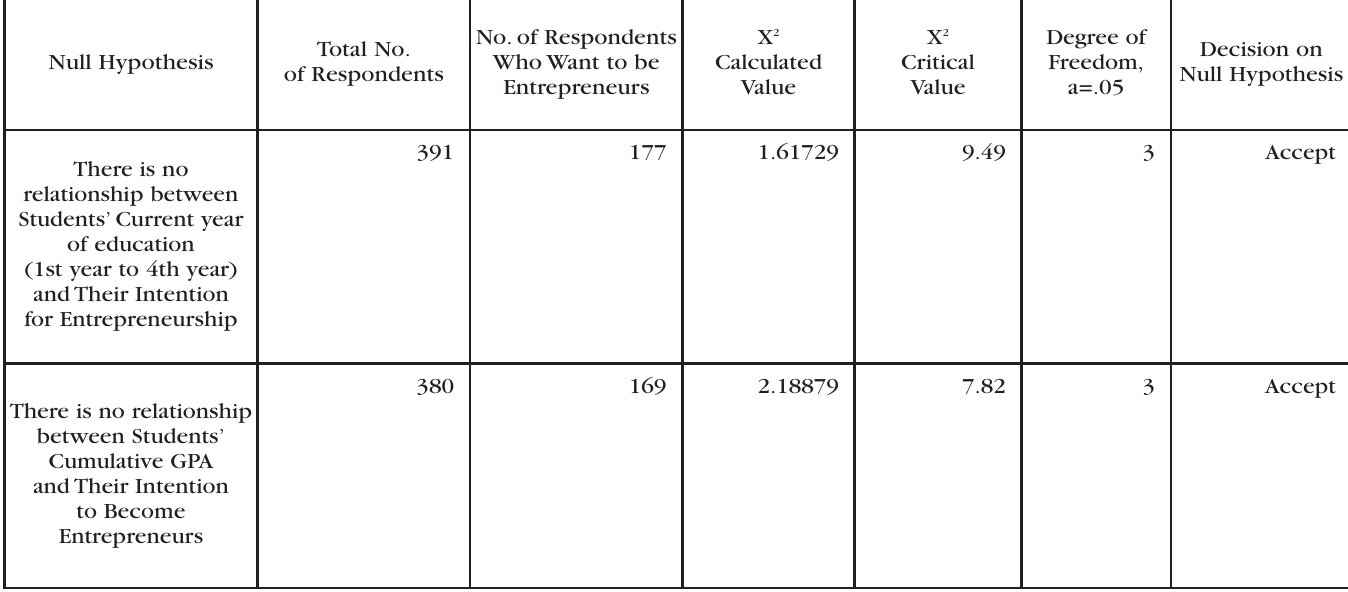
Figure 2. Relationship between Selected Variables and Students’ Intention for Entrepreneurship